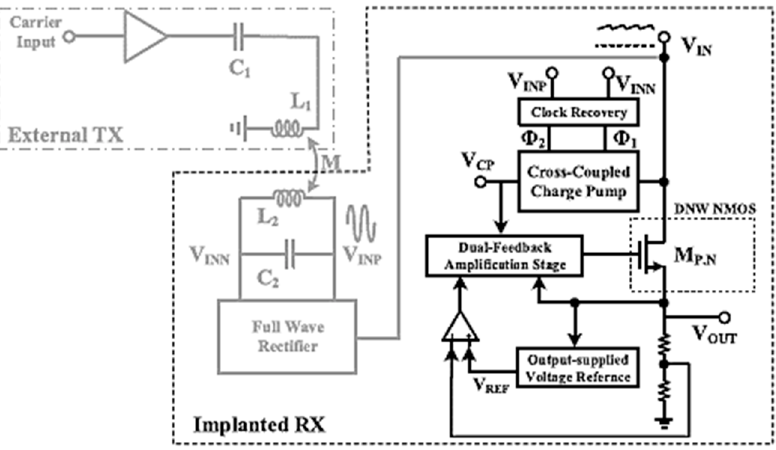
Figure 16. High PSR linear regulator [44].